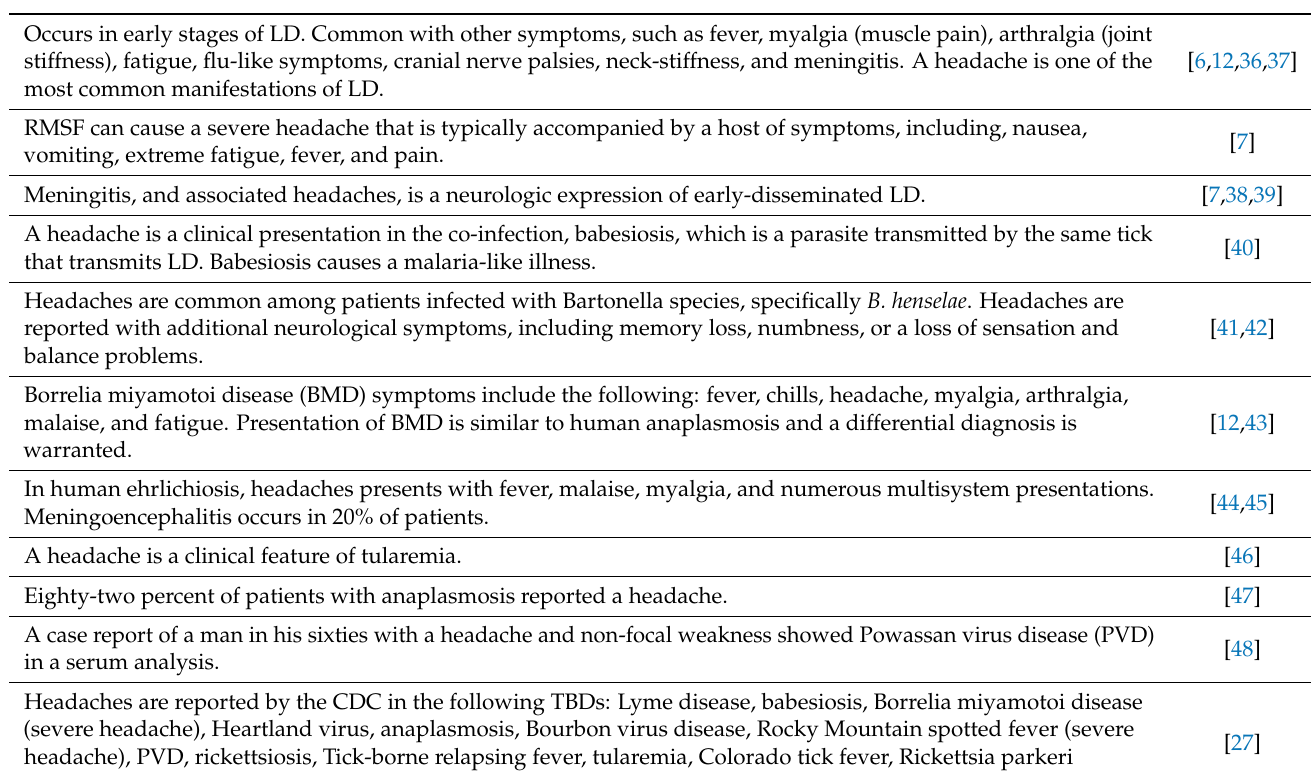
Table 1. Headache is a common feature of many TBDs. It often presents with other neurological symptoms. Case reports and scholarly literature indicate headache occurs in LD, Borrelia miyamotoi disease (BMD), and Powasan Virus, among others.